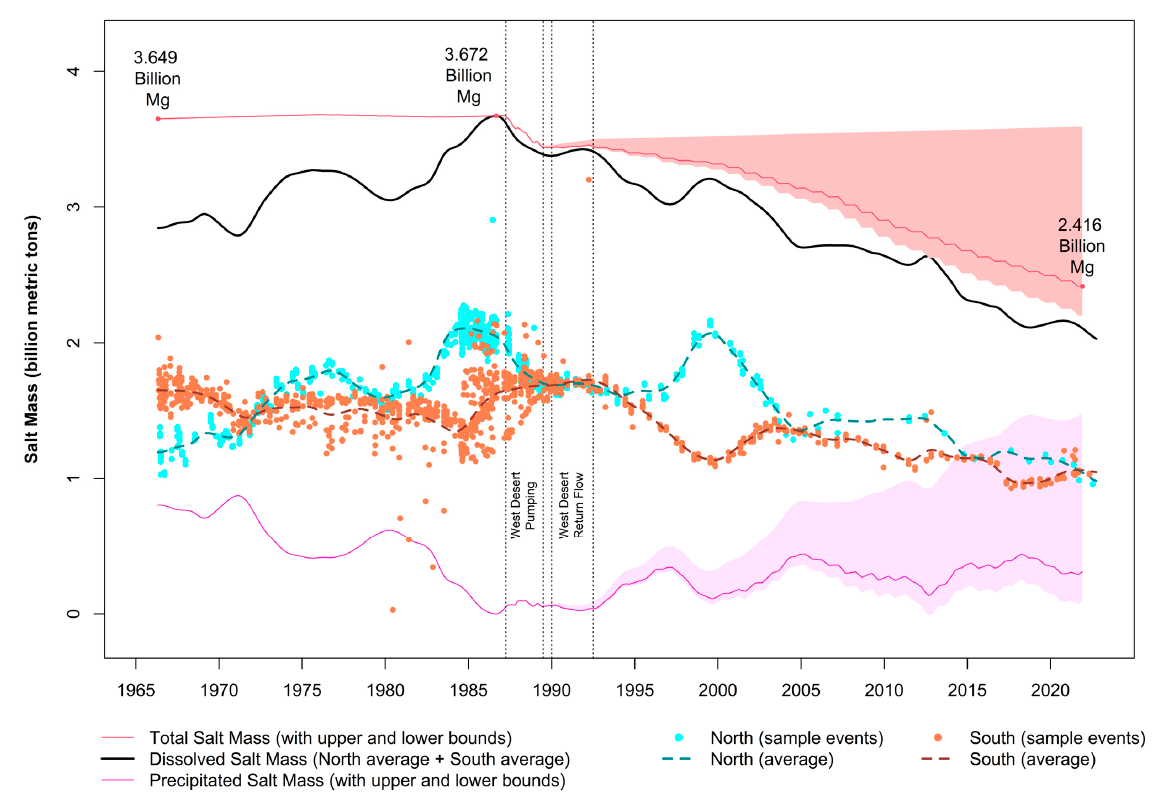
Figure 10. North and south arm salt mass calculations over the period of record at the UGS and USGS measurement sites shown in Figure 1. Calculations were only performed for sample events with 3 or more samples at depth. 1 Mg = 1 metric ton.